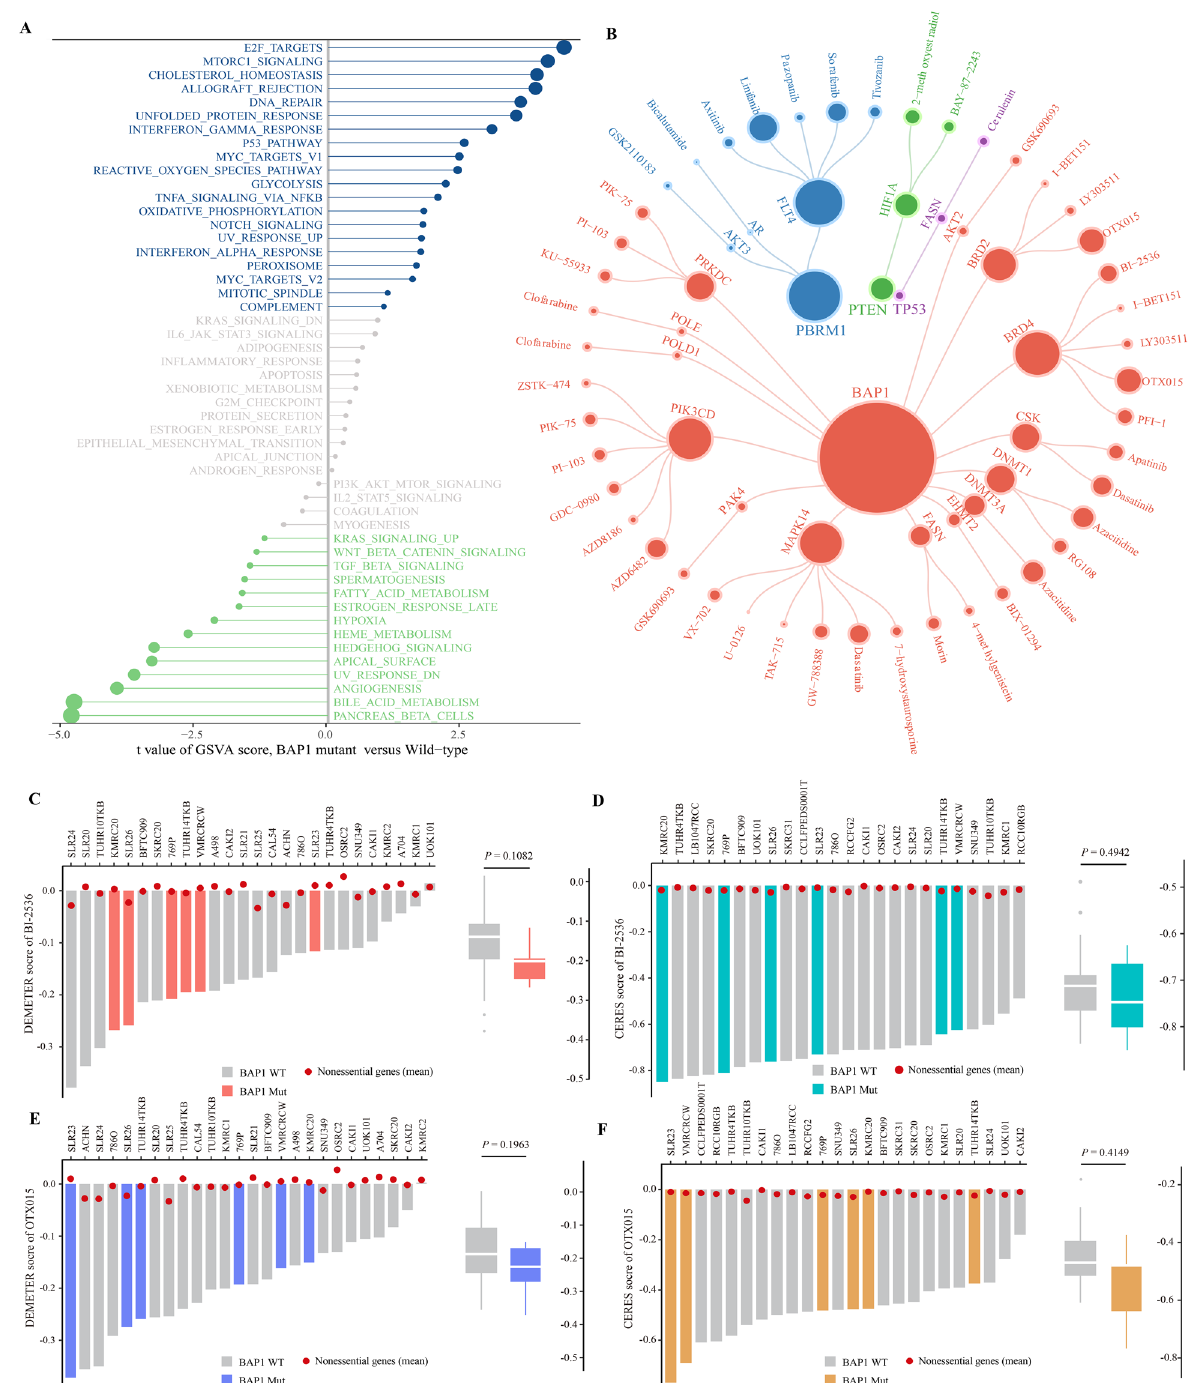
Figure 4. Determining sensitivities of identified drugs on renal cancer cell lines. ( A ) Gene set enrichment analysis between BAP1 mutated and wild-type groups. Blue dots indicate BAP1 mutant-enriched pathway, while red dots indicate wild type-associated pathways. ( B ) The bipartite network of representative TSG-DT-drug interactions. ( C ) The DEMETER scores derived from RNAi screens of BI-2536 across 24 kidney CCLs. ( D ) The CERES scores derived from CRISPR knockout screens of BI-2536 across 26 kidney CCLs. ( E ) The DEMETER scores derived from RNAi screens of OTX015 across 24 kidney CCLs. ( F ) The CERES scores derived from CRISPR knockout screens of OTX015 across 26 kidney